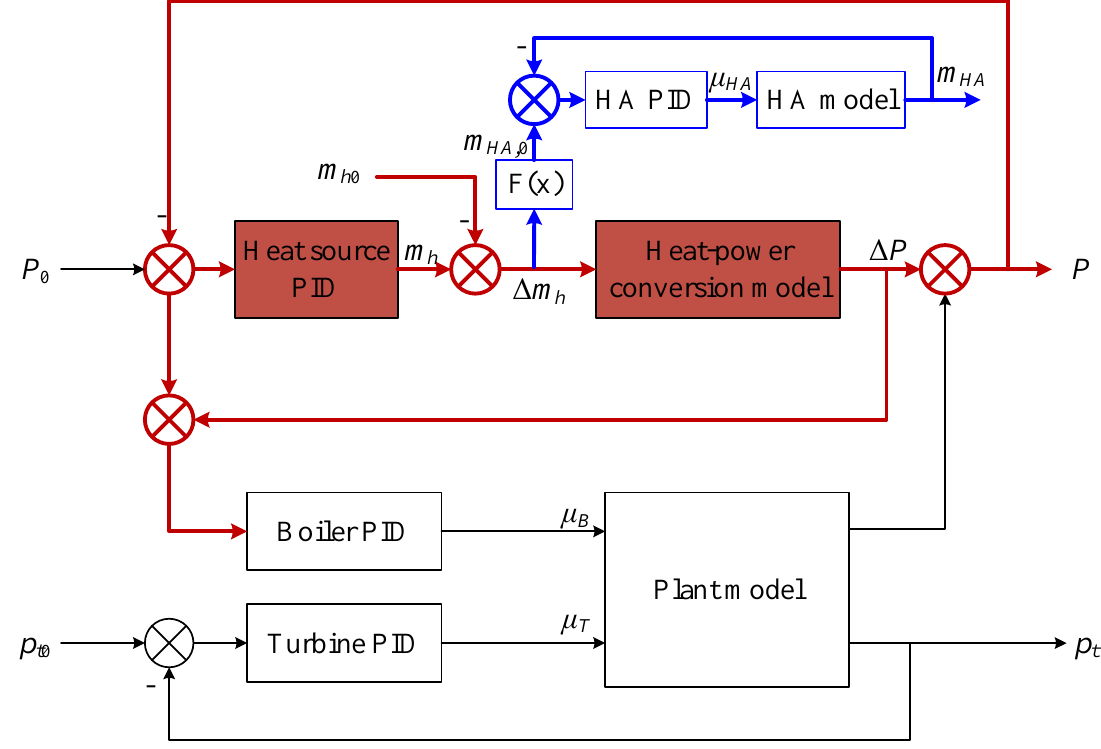
Figure 5. Optimized control strategy structure by combinations of CCS and heat source regulation.